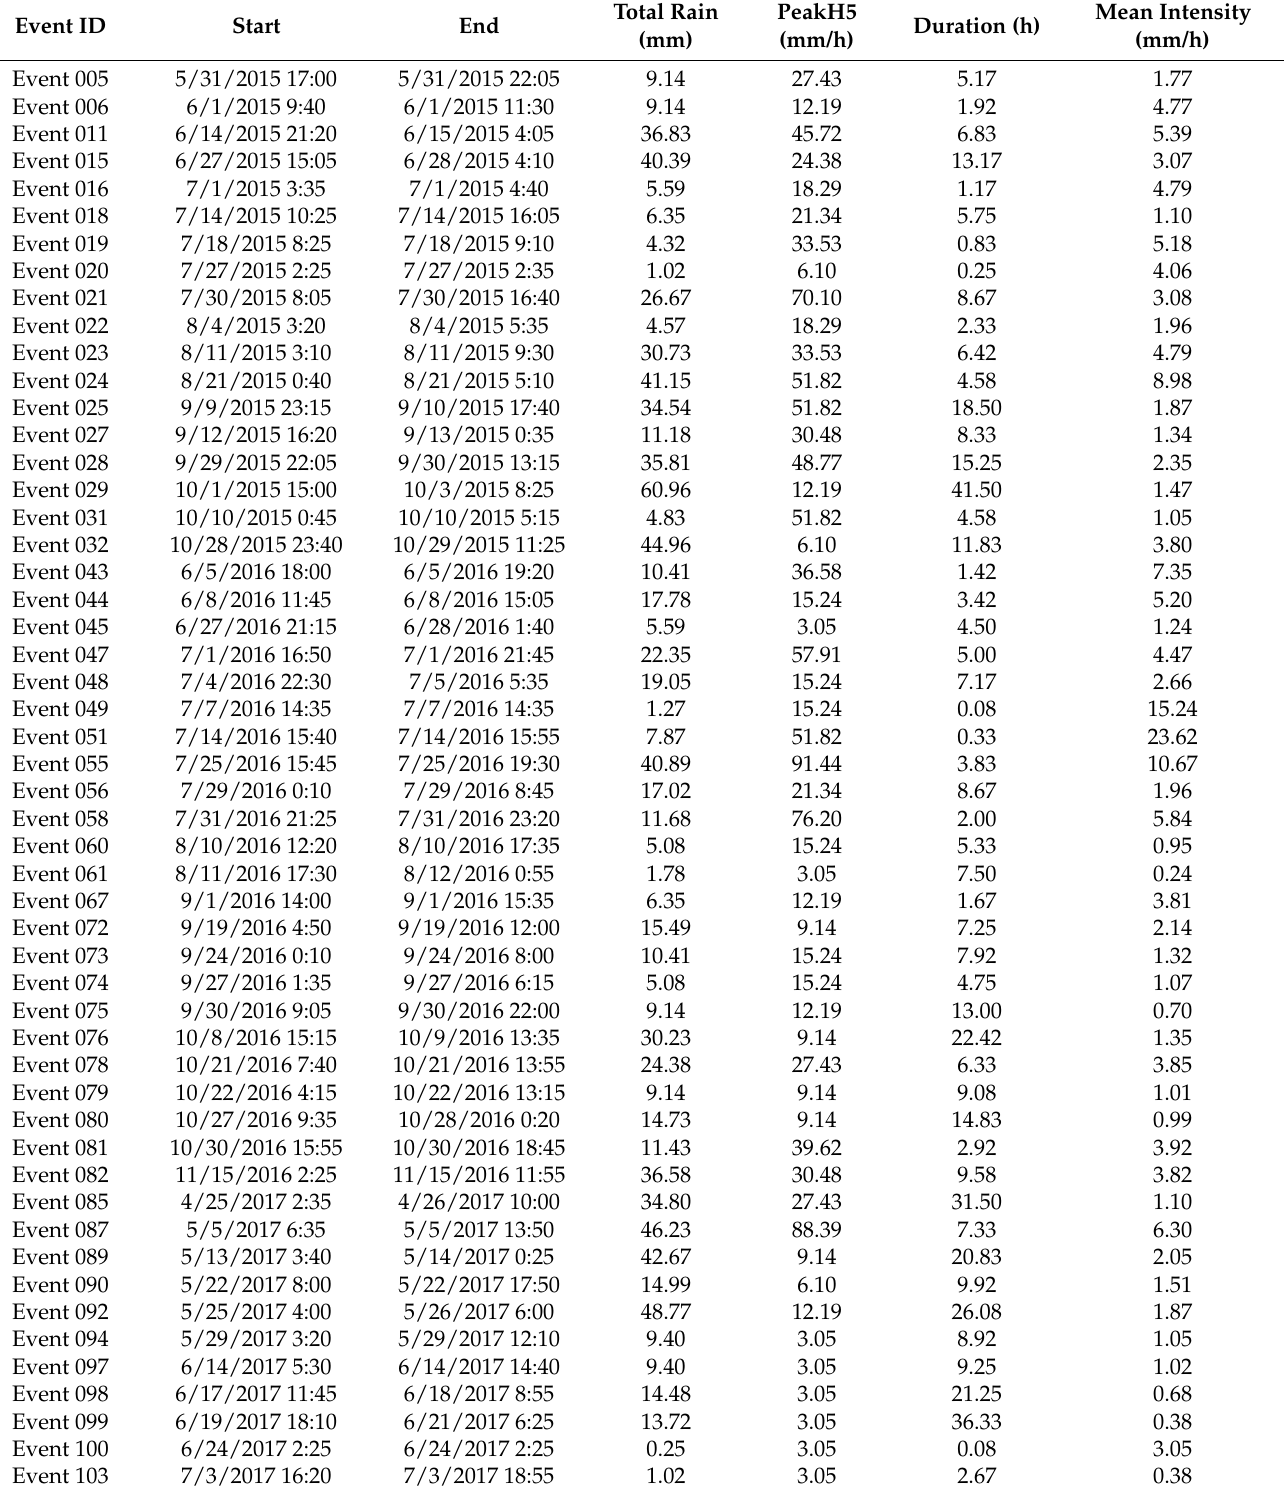
Table A2. Precipitation events at Nashville